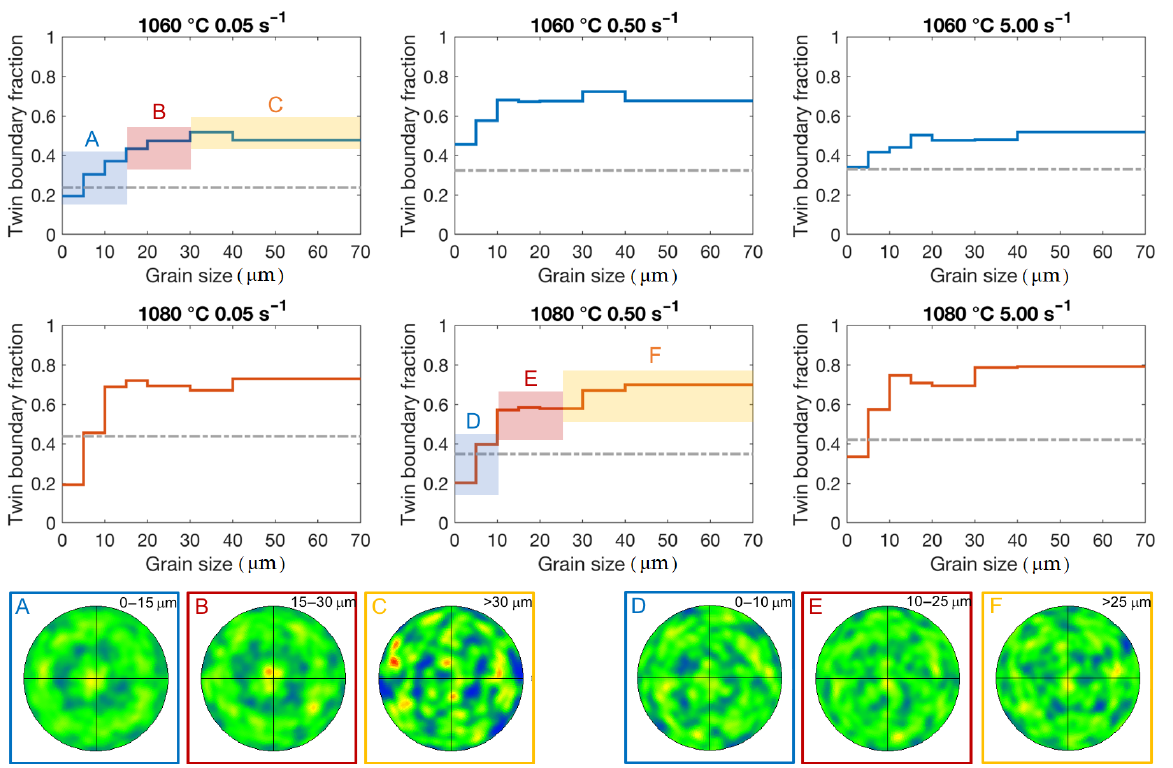
Figure 17. Fraction of twin boundaries with increasing grain size for H samples, including { 110 } pole figures corresponding to marked subsets (A–C for grain sizes 0–15, 15–30 and > 30 µ m respectively, for the sample deformed at 1060 ◦ C, 0.05 s − 1 and D–F for grain sizes 0–10, 10–25 and > 25 µ m respectively for the sample deformed at 1080 ◦ C, 0.5 s − 1 ). The gray lines dash-dotted lines correspond to the average twin boundary fraction of the entire data